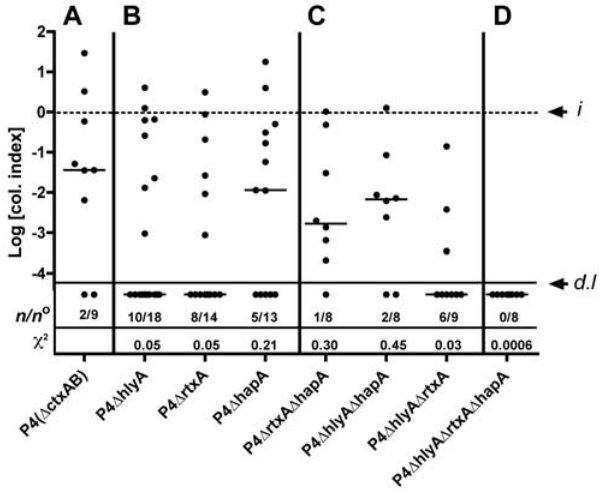
Figure 3. Colonization of the small intestine depends on accessory toxins. Data represent merged results from 4 experiments, wherein C57BL/6 mice were inoculated by the ABL strategy with a low dose between 4 6 10 5 to 4 6 10 6 CFU and colonization of the small intestine was assessed after 48 hr. Values are reported as a Col. Index as described in Fig. legend 1. Despite variation in input, there was no correlation between increased inoculum and improved colonization in these data sets. The number of mice that cleared the infection over the total mice in the experimental group is shown in the graph as number cleared ( n ) over number inoculated n u . Number of mice varies since single mutant knockout infections were repeated more often with more mice per group to assure that observed differences in clearance frequency initially observed were reproducible and not representative of experiment to experiment variation or due to differences in the inoculum.